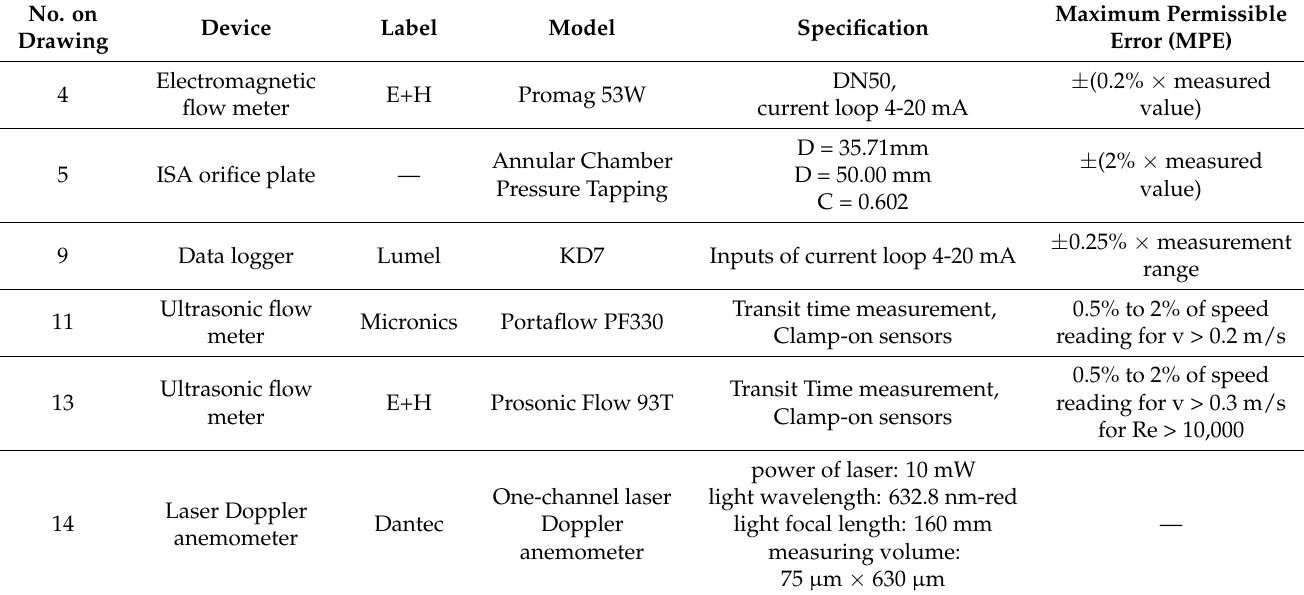
Table 1. Characteristic values of measuring devices.